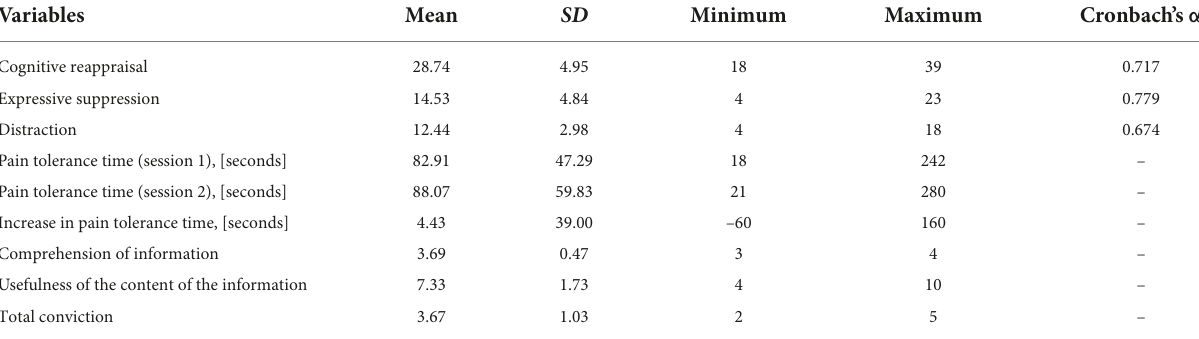
TABLE 1 Descriptive statistics.